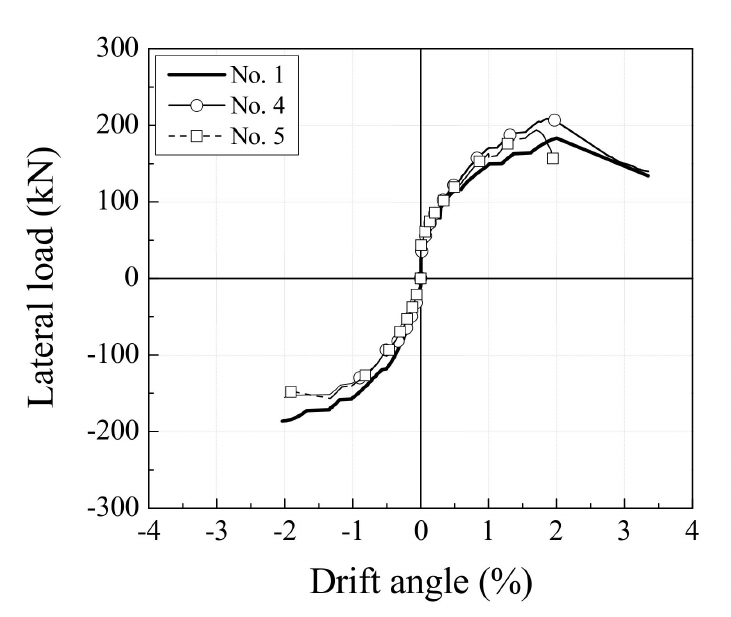
Figure 9. E ff ect of spacing of web opening on ultimate load and